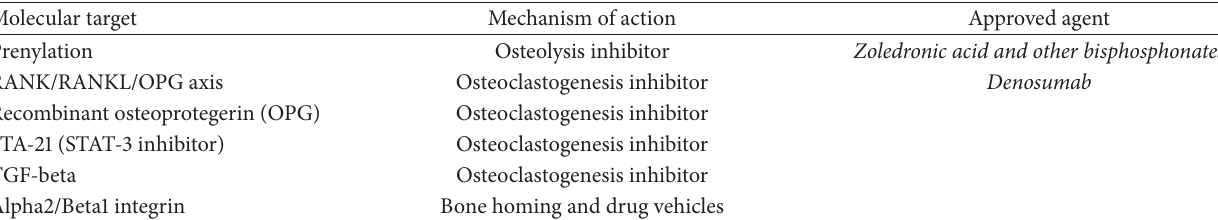
Table 1: Traditional and potential therapies for